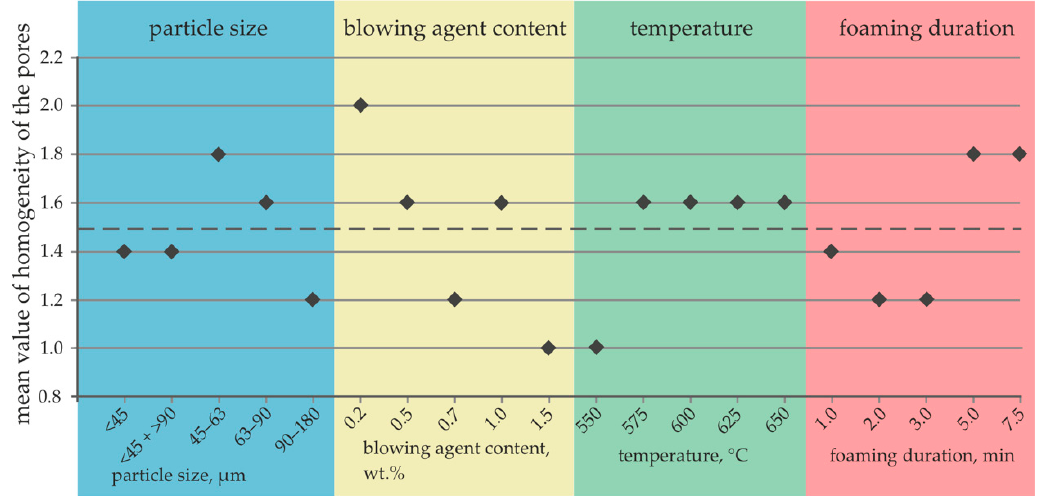
Figure 16. DoE evaluation of the effects of the investigated factors on the quality characteristic of the homogeneity of the pores.